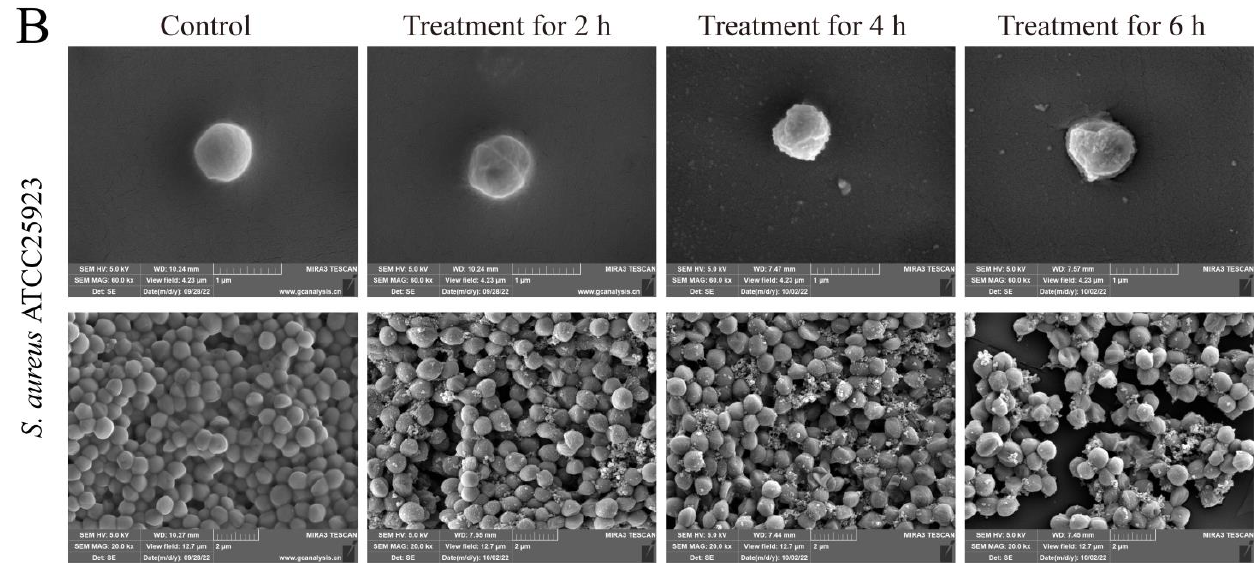
Figure 4. The SEM observation of cell surface structure of the two bacterial strains treated with the 1 × MIC of Fragment 1 for different times. (A): V. parahaemolyticus ATCC17802; (B): S. aureus ATCC 25923.